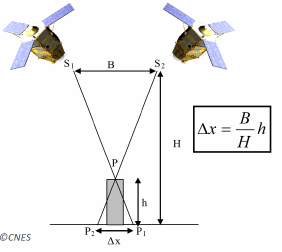
Figure 1. Stereo DSM computation.